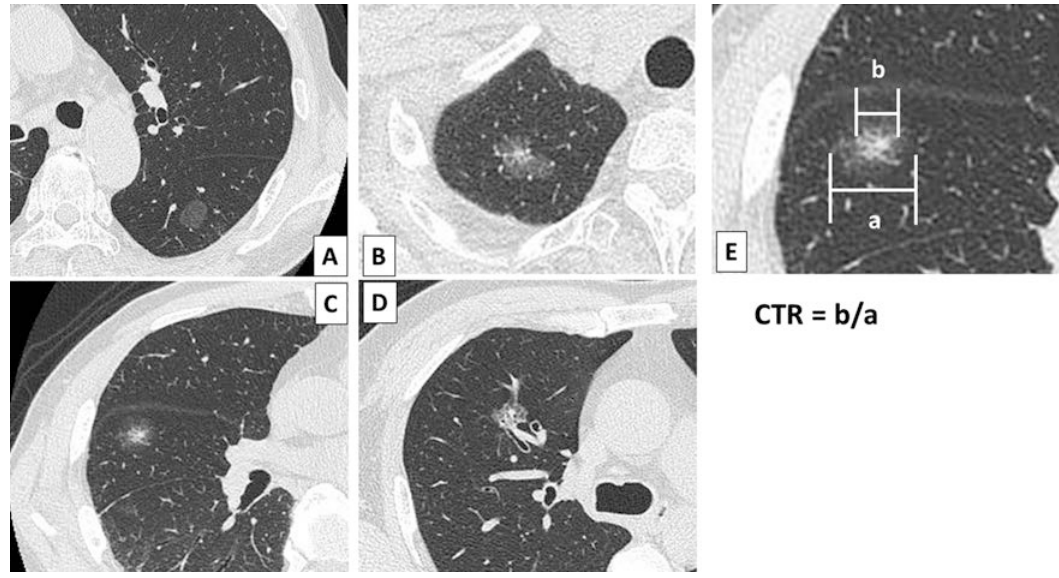
Figure 1 Representative images of classification according to the consolidation-to-tumor ratio (CTR). (A) CTR=0 (pure GGN; i.e., nodule containing only ground-glass opacity), (B) CTR>0 and ≤25, (C) CTR >25 and ≤50, and (D) CTR >50 and ≤75. (E) The CTR was defined as the ratio of the maximum size of consolidation to the maximum tumor size on thin-slice